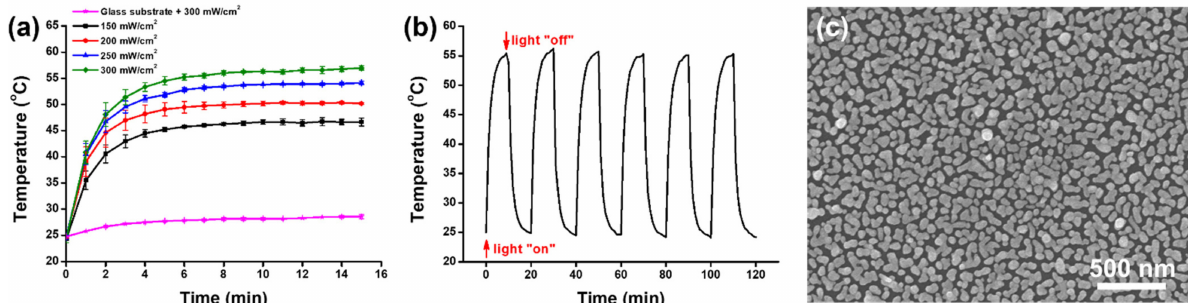
Figure 5. ( a ) Photothermal effects of the glass substrate and the gold nanoisland film (AuNIF) under simulated AM1.5 sun- light irradiation. ( b ) Photothermal performance of the AuNIF under on/off cycles of simulated AM1.5 sunlight irradiation at a power density of 300 mW/cm 2 . ( c ) SEM image of the AuNIF after the on/off cycles of the simulated AM1.5 sunlight irradiation at power density of 300 mW/cm 2